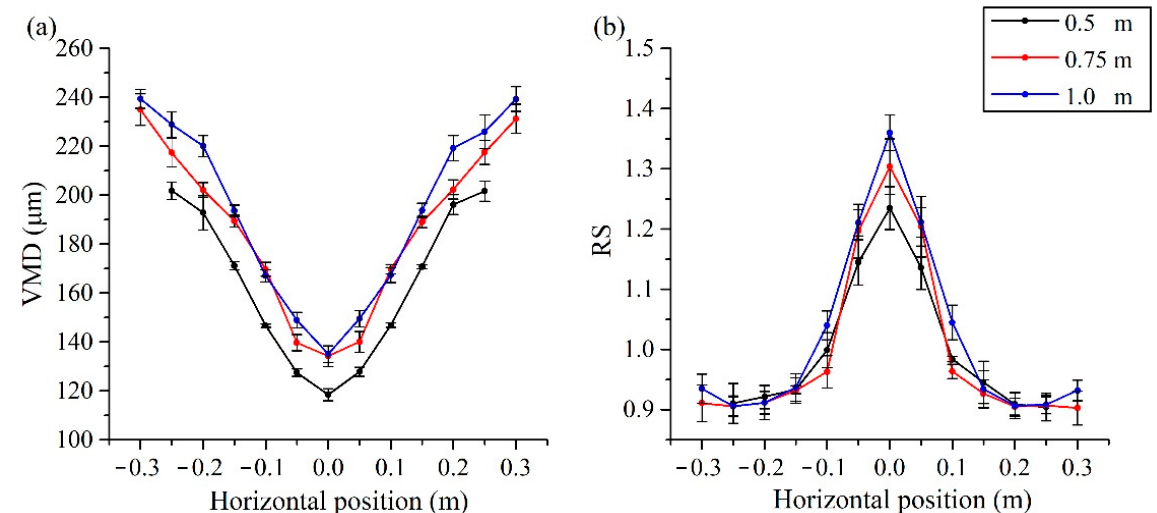
Figure 3. Droplet size distribution at different spatial positions: ( a ) VMD; ( b ) RS.